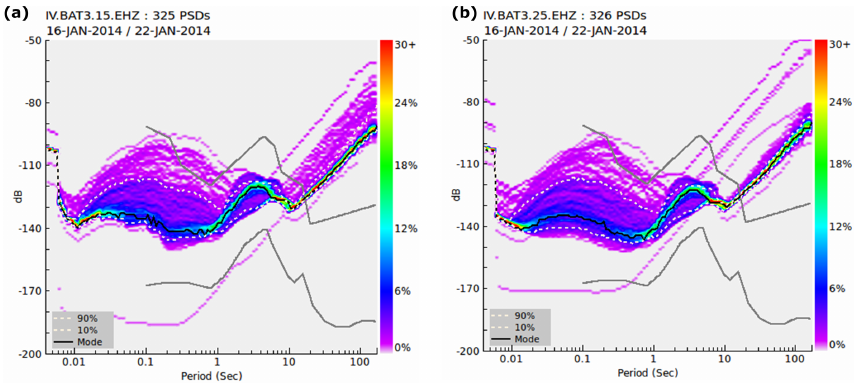
Figure 4. Power spectral density computed from data recorded during one week at BAT3 at a depth of 150 (a) and 250 (b) m.